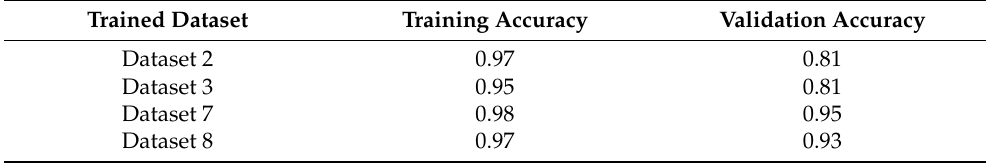
Table 2. Comparison with other datasets for testing accuracy and calculation time.